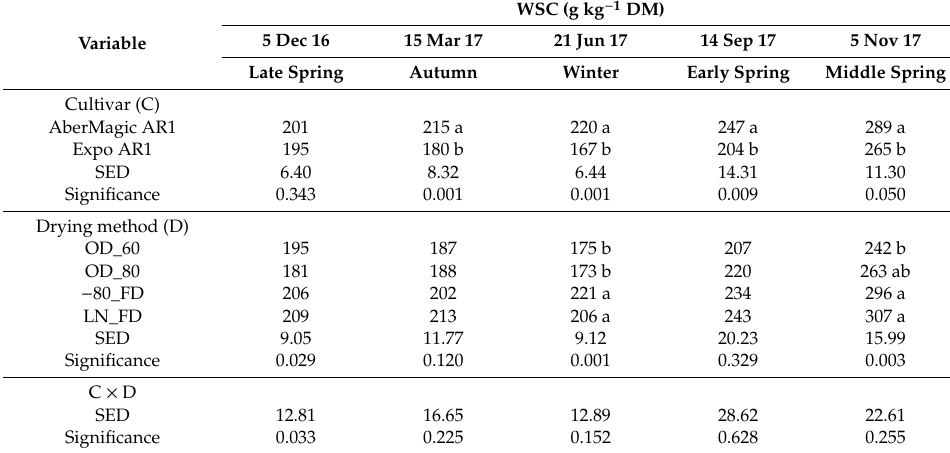
Table 1. Water-soluble carbohydrate concentration (WSC, g kg − 1 DM) in AberMagic AR1 and Expo AR1 dried under di ff erent procedures in five harvests.